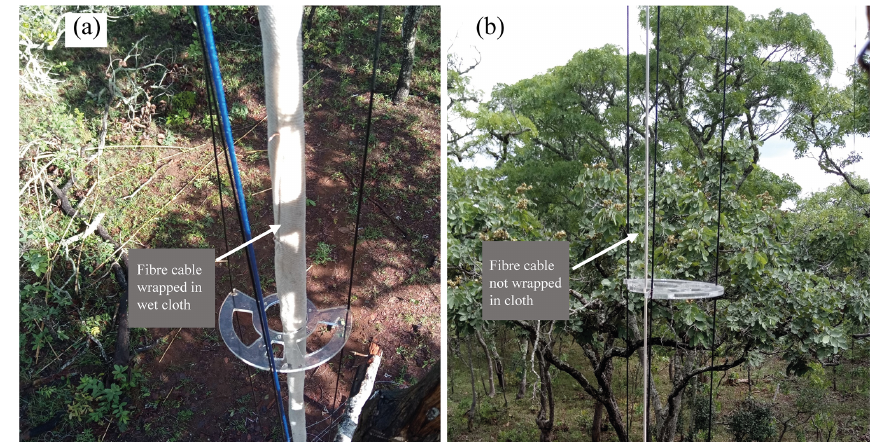
Figure 4. Optic fibre cable wrapped in the wet cloth (a) for collecting the wet bulb temperature, and (b) optic fibre cable not wrapped in cloth for estimating the dry bulb temperature on the observation tower at Mpika site, Zambia. Under canopy view without